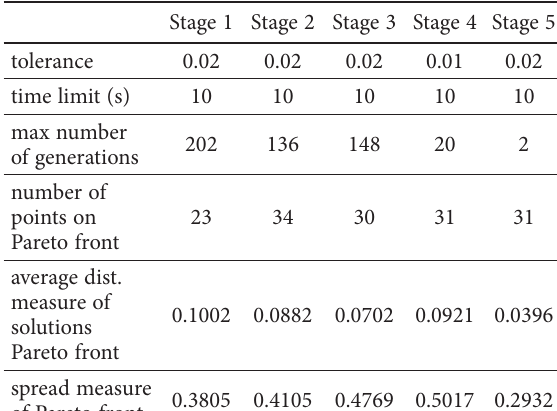
Table 1. GA and GHA input controls and output